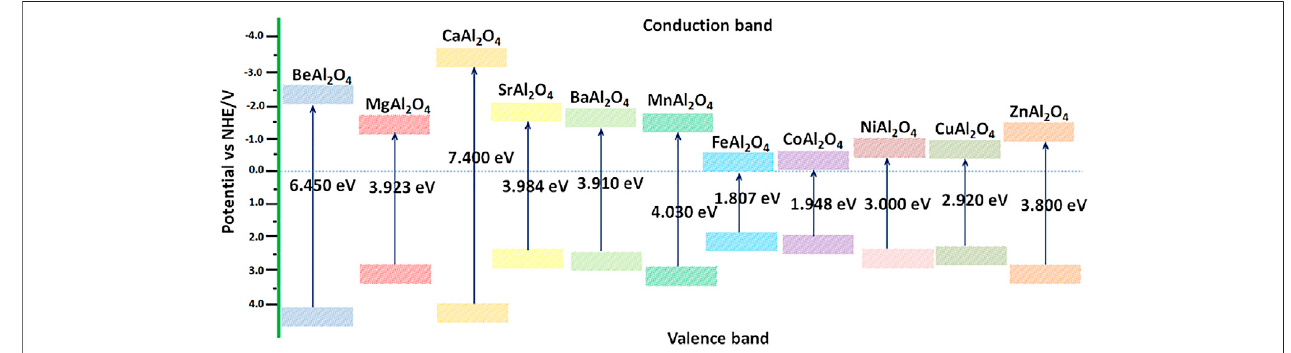
FIGURE 1 | The related energy level diagram of MAl 2 O 4